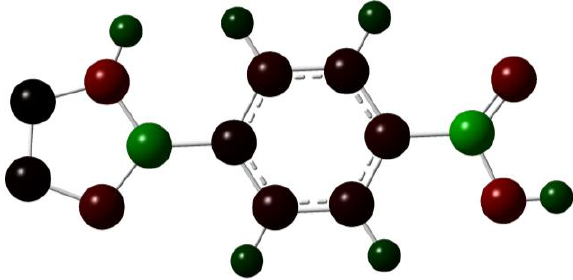
Figure 2. Computational analysis of TBC ligand. The color demonstrates the charge distribution within the molecule. The red indicates a negative charge, green a positive charge, and black a neutral